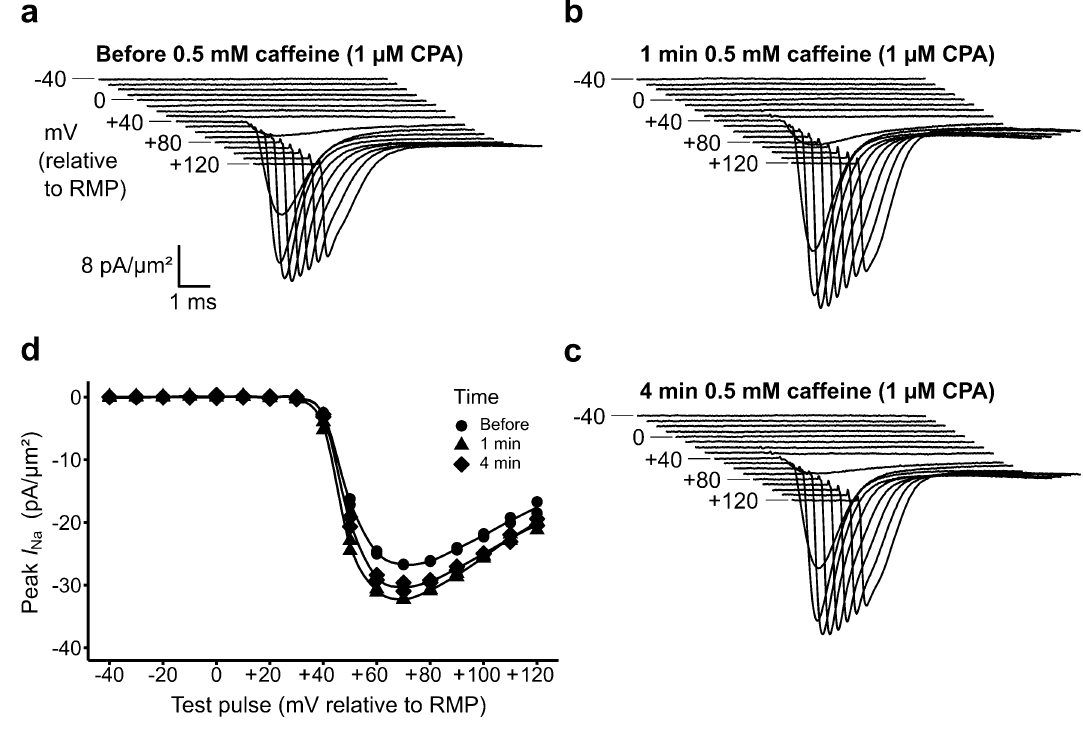
Figure 5. Effects of 0.5 mM caffeine challenge in the presence of 1 µM CPA. ( a – c ) Families of current traces from a patch ( a ) before, ( b ) 1 min and ( c ) 4 min after a preparation first pre-incubated with 1 µM CPA